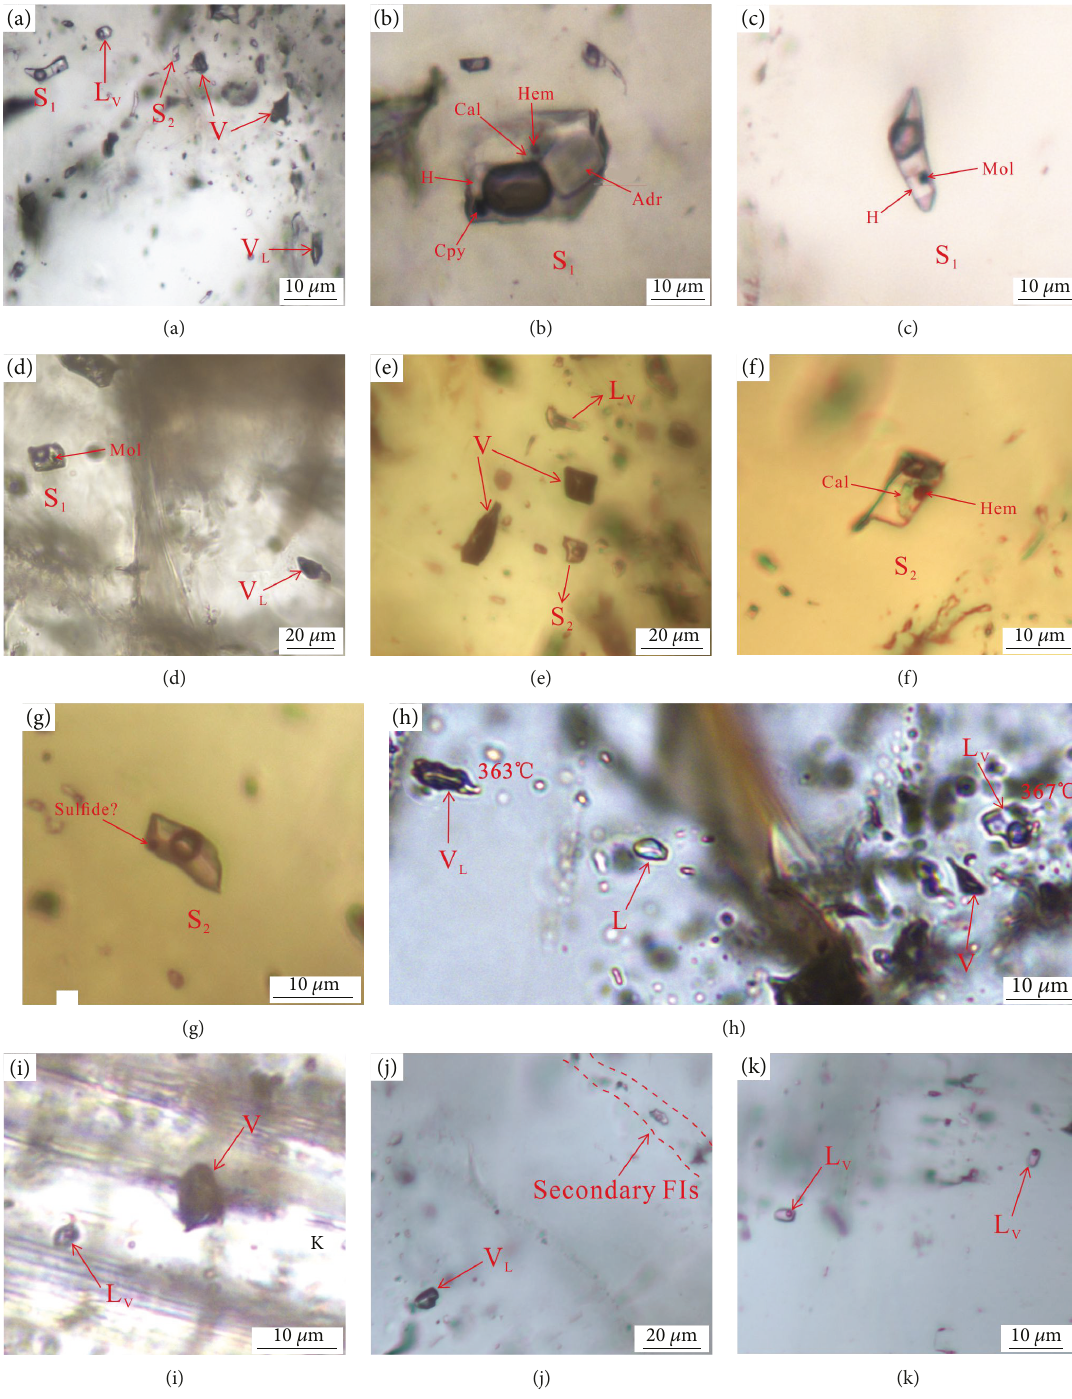
Figure 8: Photomicrographs of representative fl uid inclusions in the Fuzishan Cu-Mo deposit. (a) A fl uid inclusion assemblage including S S -, L -, V -, and V-type inclusions in garnet of the prograde skarn stage. (b) A typical S 2 V L minerals in garnet of the prograde skarn stage. (c) S type inclusions in the cubic diopside of the prograde skarn stage. (e) A fl uid inclusion assemblage comprising S in epidote of the retrograde skarn stage. (f) A typical S epidote of the retrograde skarn stage containing dark opaque daughter mineral, possibly being sul fi de. (h) Coexistence of L V -type inclusions in quartz of the quartz-sul fi de stage. (i) Coexisting L L and secondary fl uid inclusions of the late anhydrite of the quartz-sul fi de stage. (k) L V L Cpy: chalcopyrite; Mol: molybdenite; Hem: hematite; Cal: calcite; Adr: anhydrite; H: